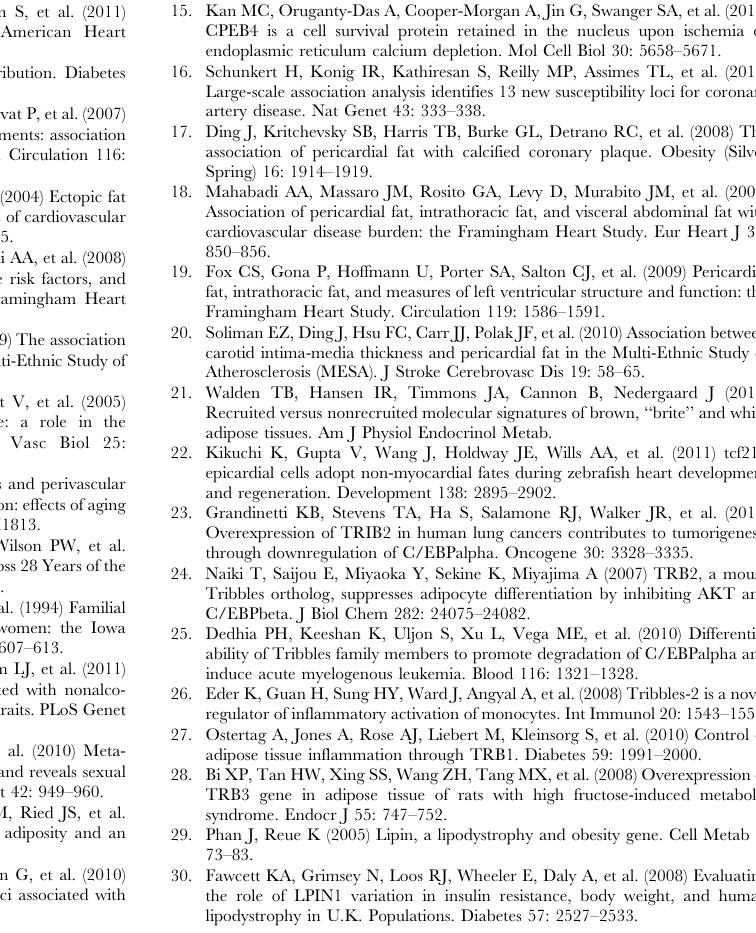
Figure S2 Manhattan plot. Figure S3 Mean normalized expression level and standard deviation for TRIB2 across a variety of fat depots. Table S1 Genotyping information for each study.